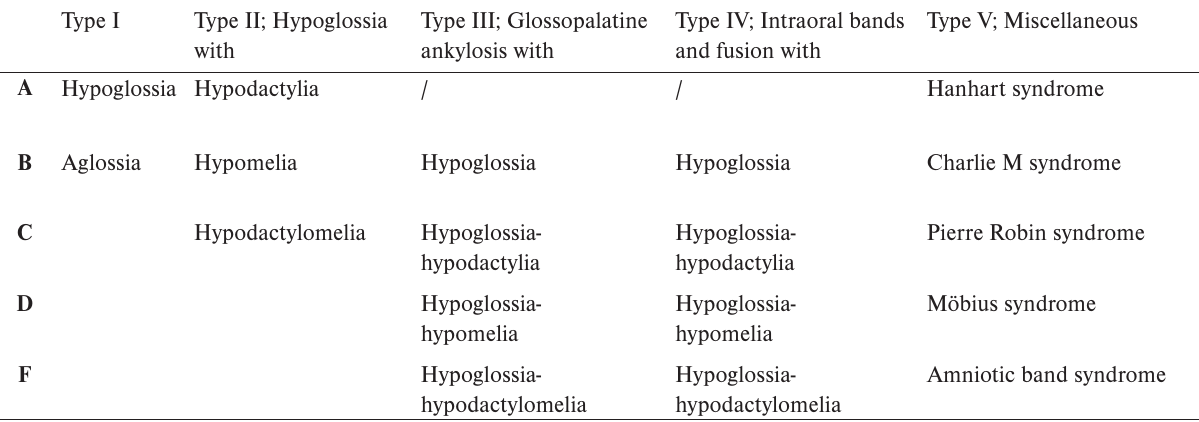
Table 1. Oromandibular Limb Hypogenesis Snydromes (OLHS): Hall classification 14